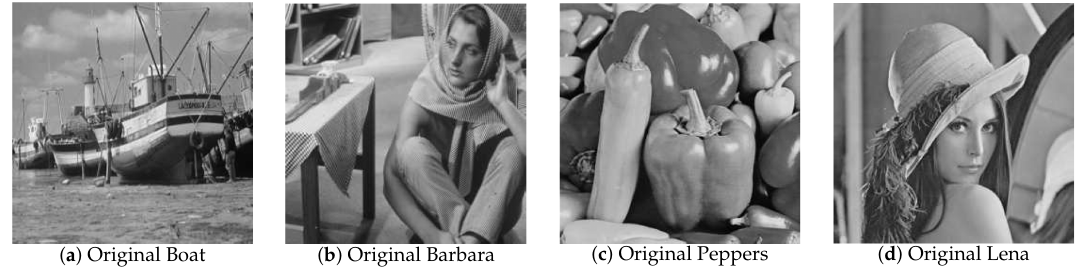
Figure 6. Original images: ( a ) boat; ( b ) Barbara; ( c ) peppers; ( d )